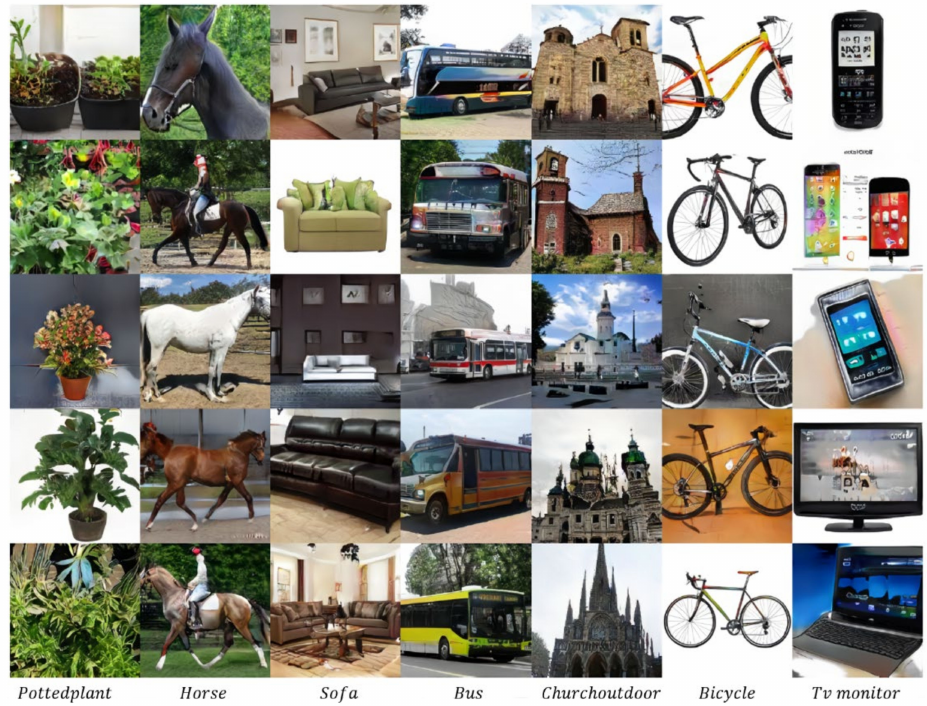
Figure 8. 256 × 256 pixel images generated by PGGAN trained with LSUN (large scale scene understanding) datasets